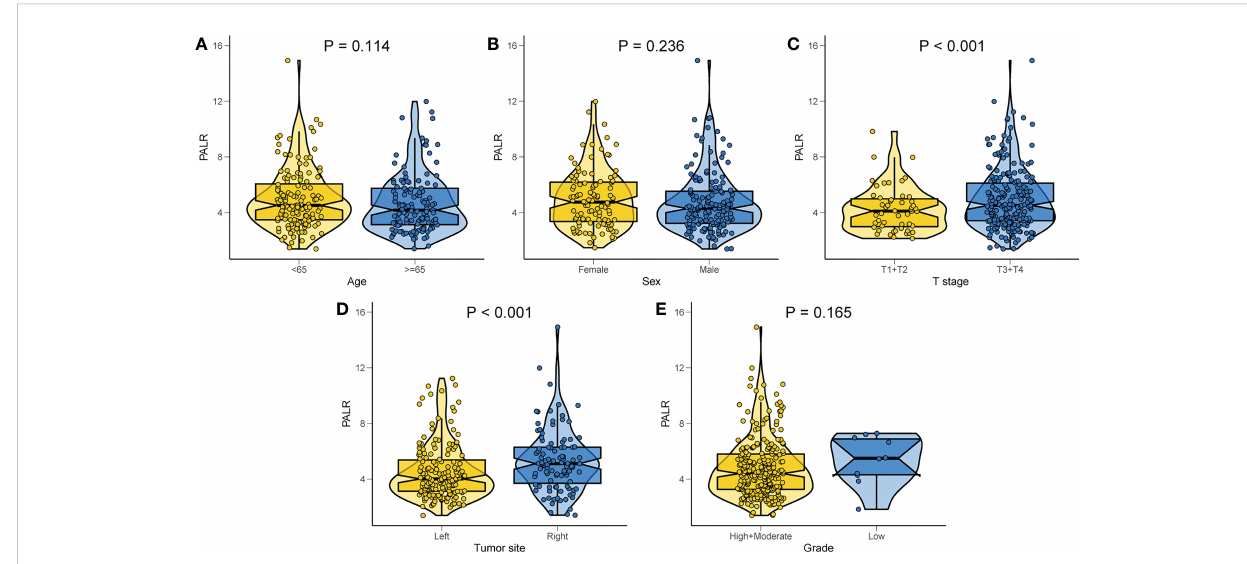
FIGURE 4 Distribution of PALR values among different clinicopathological variables. (A) Age, (B) Sex, (C) T stage, (D) Tumor site, (E)